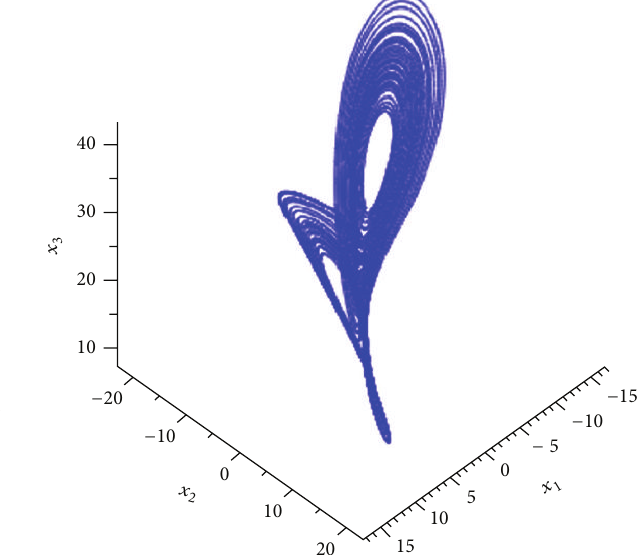
Figure 1: The chaotic attractor of Lorenz system when (𝛼,𝛽,𝛾) = (10, 28,